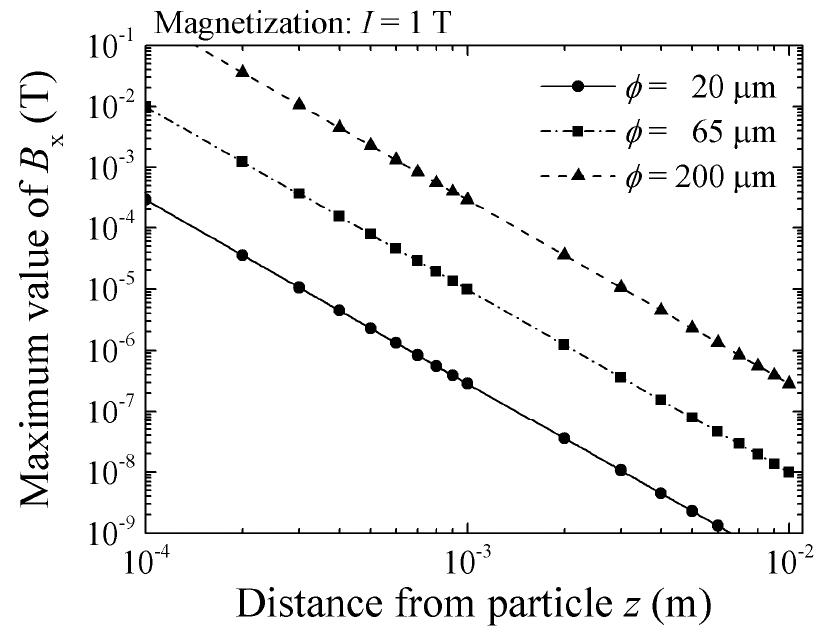
Figure 5. Simulated variation of flux density, B x , as a function of particle height, z , in case of particle magnetization 1.0 T [21].